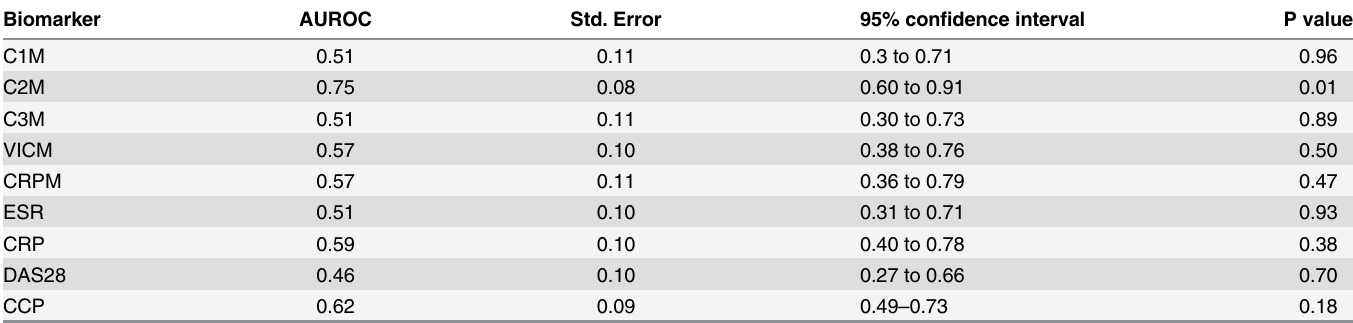
AUROCs discriminating between non-erosive and erosive disease for patients ful fi lling the RA criteria after 2 years of follow-up. Signi fi cance levels were set to p < 0. 0056 when corrected for